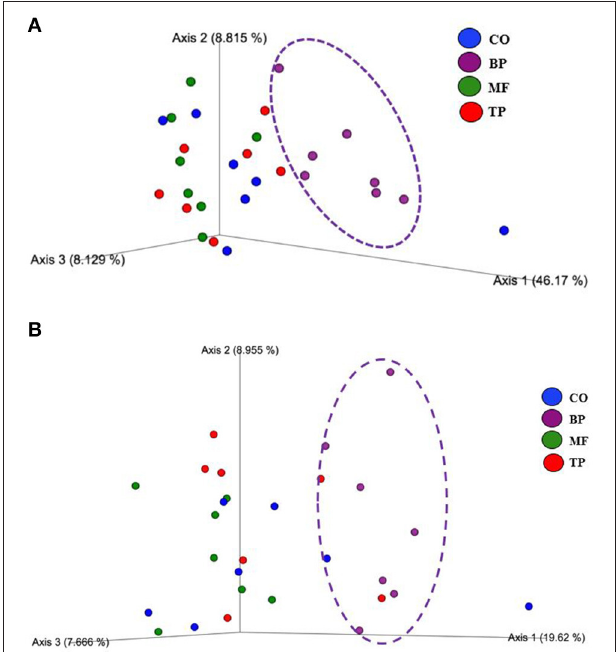
FIGURE 2 | Principal coordinated plots of weighted (A) and unweighted (B) UniFrac distances of fecal microbial communities of cats fed diets containing traditional and novel fiber sources.